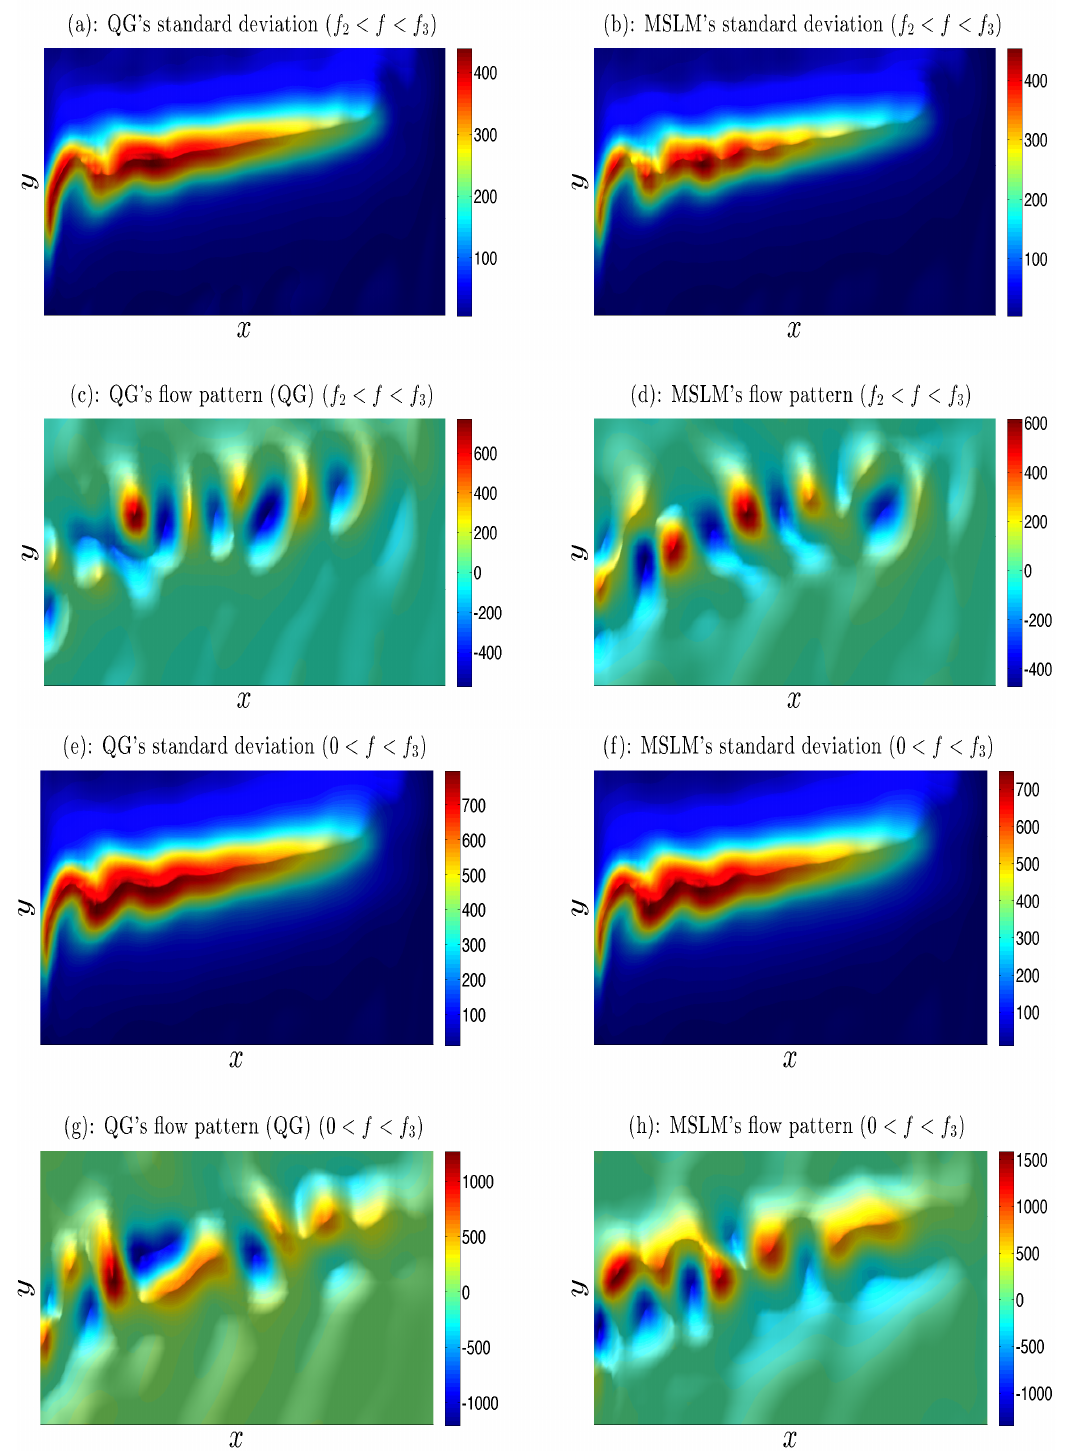
Figure 9. Upper-level stream function anomalies and standard deviation: QG vs. MSLM. The QG’s standard deviation (SD) and its MSLM emulation are shown here in Panels ( a , b ), respectively, for the high-frequency range f 2 = 5.27 y − 1 < f < f 3 = 9.1 y − 1 . Panels ( c , d ) depict typical flow patterns underlying the SD patterns for the QG model and MSLM, respectively. Panels ( e , f ) (resp. ( g , h )): same as for Panels ( a , b ) (resp. ( c , d )), but for the full range of frequencies 0 < f < f 3 = 9.1 y − 1